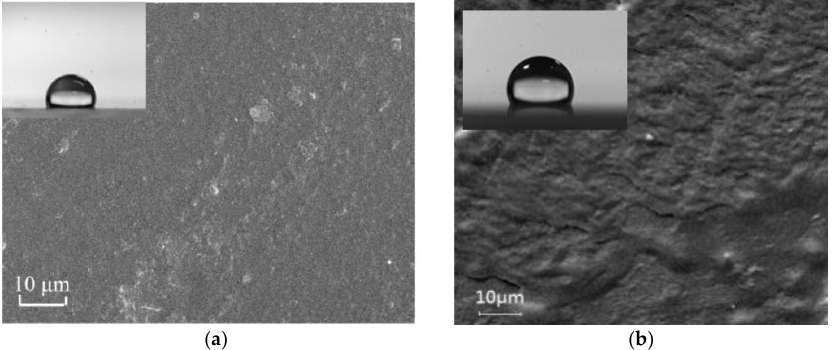
Figure 5. SEM photographs of FVPS and FSi@SiO 2 coating on toughened glass: ( a ) FVPS, WCA = 110.2 ◦ ; ( b ) FSi@SiO 2 , WCA = 120.3 ◦ .